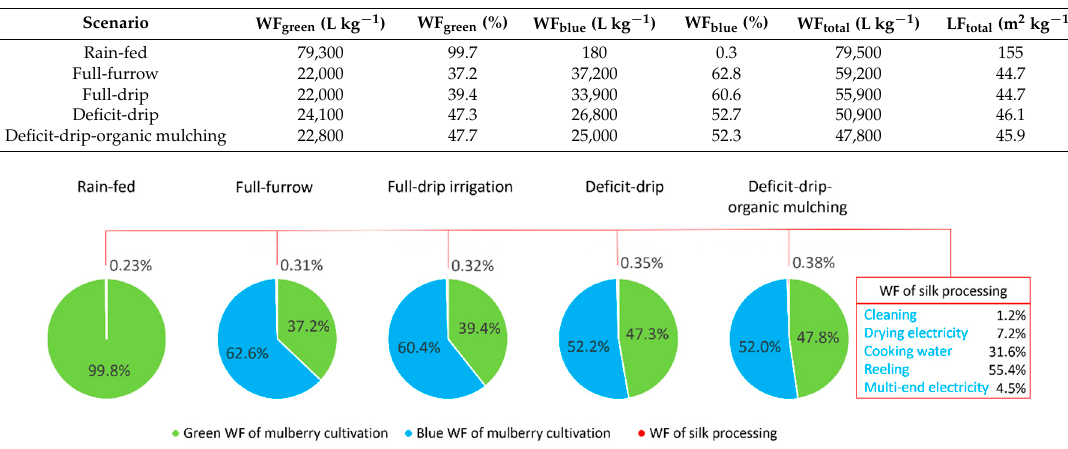
Table 5. Green, blue and total water footprint (WF) and land footprint (LF) of silk under five mulberry cultivation scenarios per kg of raw silk.